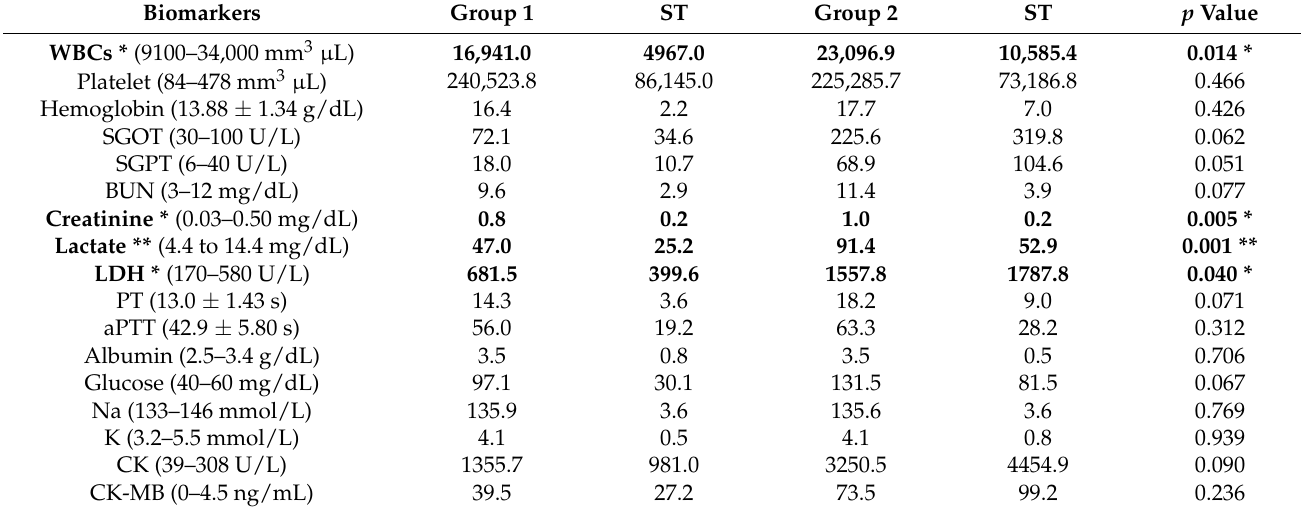
Table 2. Differences in blood biomarkers between group 1 (mild HIE) and group 2 (moderate and severe